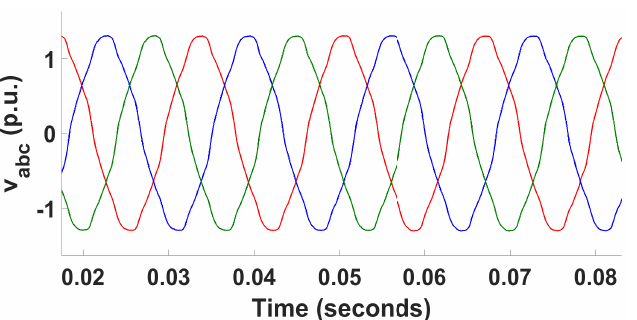
Figure 14. Balanced grid voltage distorted by 5th, 7th, 11th, 13th, 17th, and 19th harmonics